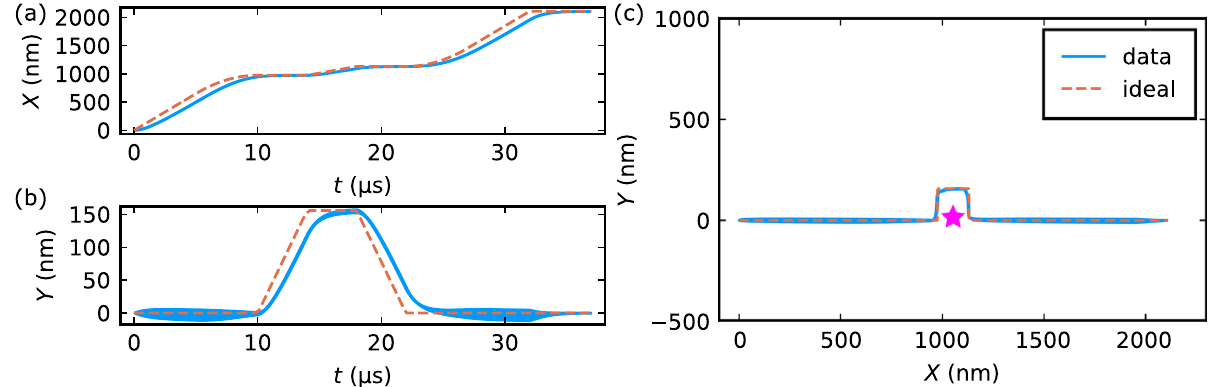
Figure 5. Deflecting skyrmion trajectory to bypass an obstacle. ( a )–( c ) Two-dimensional control of skyrmion motion by detuning the frequencies of standing SAWs in both x and y directions for detouring an obstacle [pink star in (c)]. ( a ), ( b ) Time dependence of ( a ) the X coordinate and ( b ) the Y coordinate of the skyrmion position. ( c ) The skyrmion trajectory obtained from the time dependence of X and Y shown in ( a ) and ( b ). Blue solid curves indicate the skyrmion motion (denoted by “data”), while orange dashed curves the trajectory of the intersection of the antinodes which traps the skyrmion (denoted by